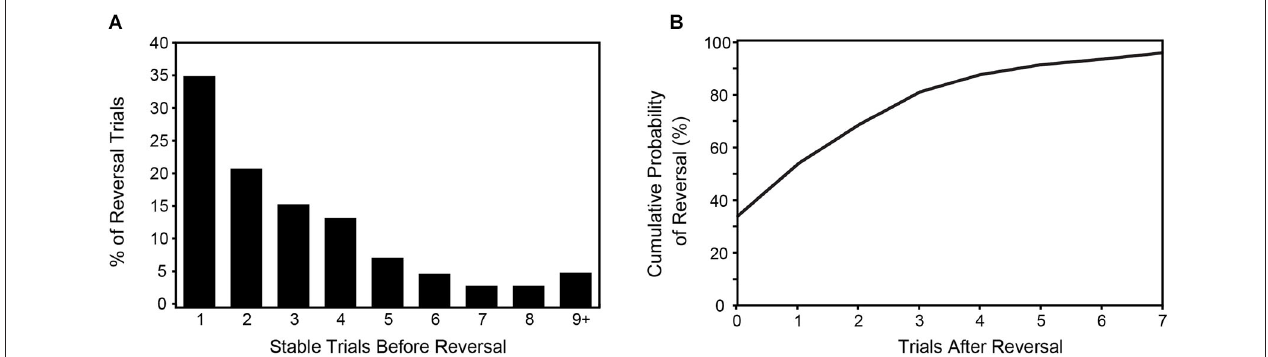
as a function of trials following a reversal (B) . Both figures demonstrate the inevitability of perceptual reversals over time, a key feature of bistable stimuli.